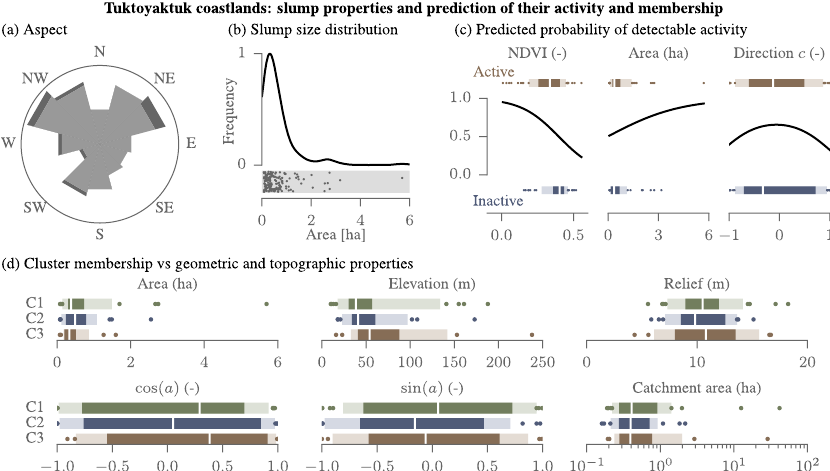
Figure 2. Statistics of thaw slumps in the Tuktoyaktuk coastlands. (a) Headwall orientations (darker colour represents slumps whose area exceeds 2ha). (b) Size distribution (histogram and scatter plot). (c) Predicted probability of activity plotted with black line for each explana- tory variable (all other explanatory variables set to their median) with observed distribution of each variable for the active slumps above and the inactive ones below (white line: median; dark colour: interquartile range; light colour: 10th and 90th percentile; dots: remaining values). The direction factor c is the cosine between look direction and headwall orientation. (d) Distribution of topographic and geometric slump properties for all three clusters of sub-seasonal activity C1–C3. a is the headwall